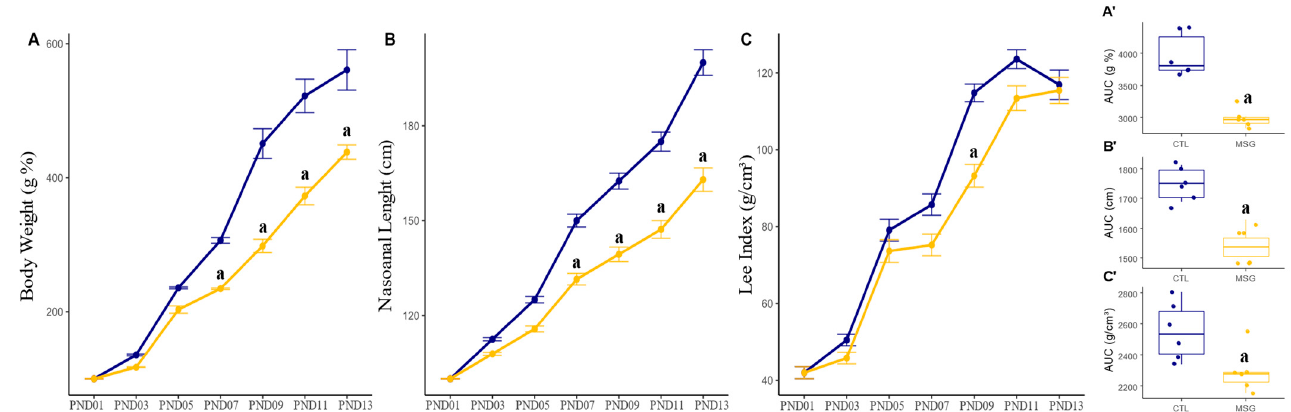
Figure 1. Graphs related to the development of CTL and the MSG animals during the perinatal period (PND01 to PND13). ( A ): Line plot of per cent weight gain (g%); ( B ): line plot of nasoanal length gain (cm); ( C ): Lee’s index gain line plot (g/cm³); ( A’ ): AUC of body weight gain; ( B’ ): AUC of nasoanal length gain (cm); ( C’ ): AUC of the Lee index gain (g/cm³). The CTL is represented in blue and the MSG group is represented in yellow. The letter a represents the difference between the MSG group when compared to the CTL. ( A – C ): repeated measurements ANOVA. ( A’ – C’ ): Student’s t-test .